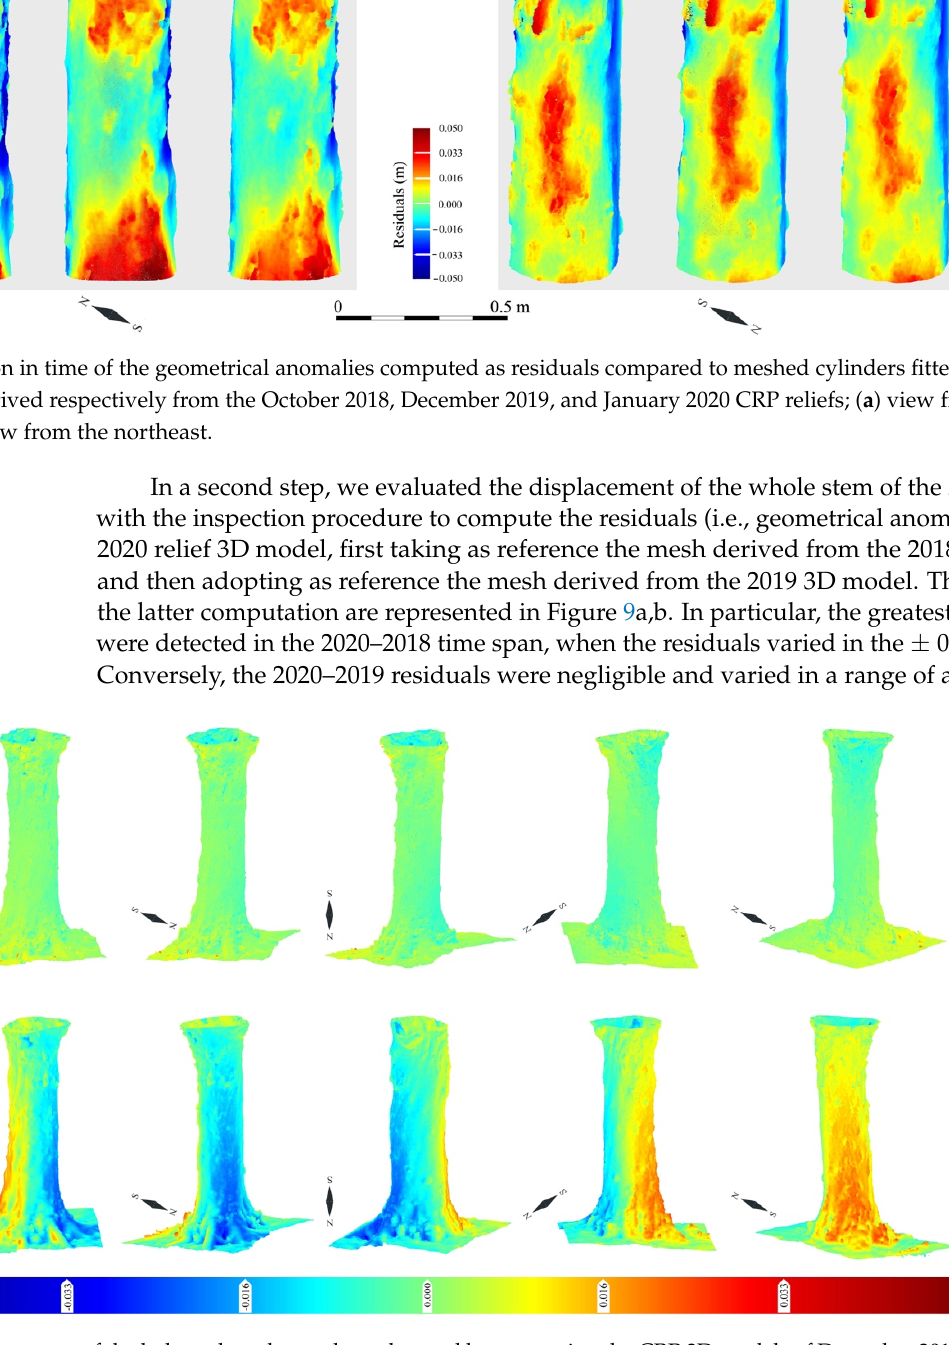
Figure 9. ( a ) Displacement of the holm oak under study as detected by comparing the CRP 3D models of December 2019, taken as reference mesh, and January 2020; residuals are expressed in m.( b ) Displacement in m obtained after the comparison of the October 2018 3D model, taken as reference mesh, and the January 2020 photogrammetric campaign 3D model.